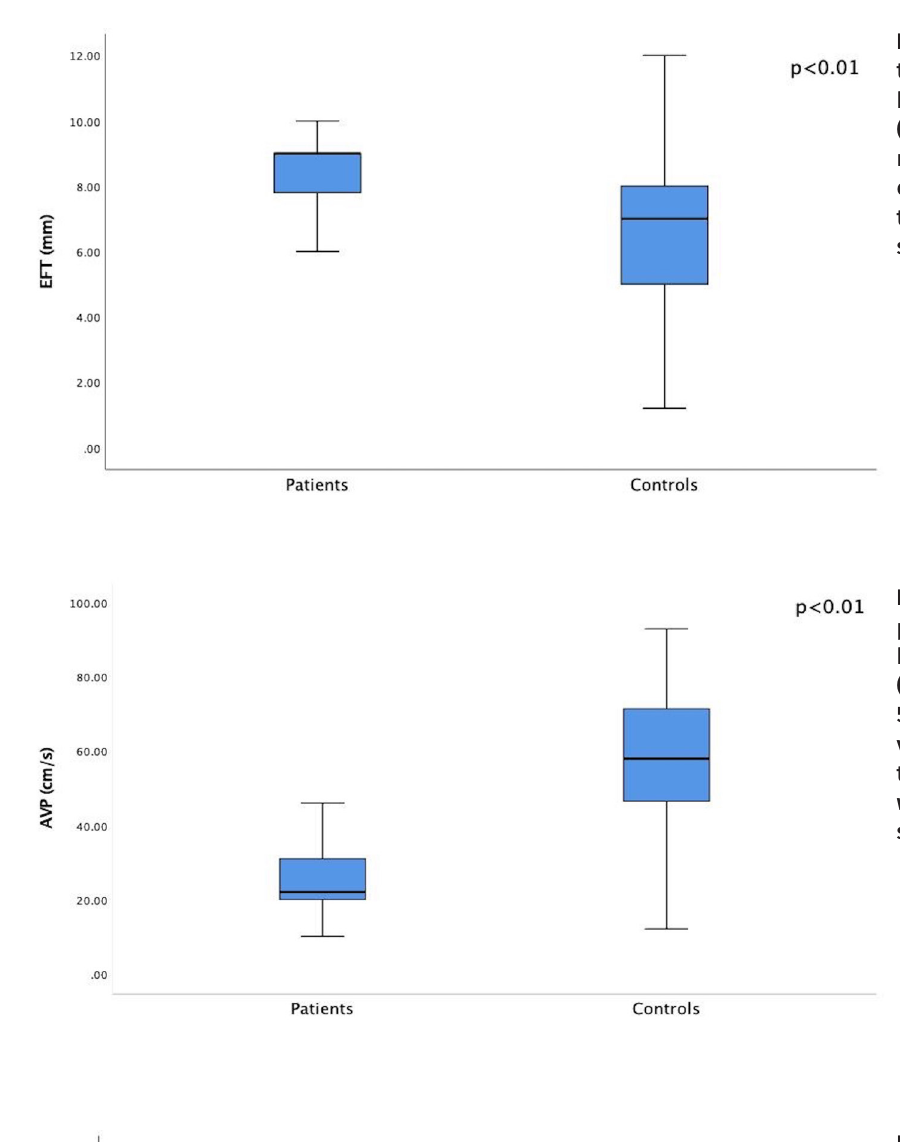
Figure 5. Carotid intima- media thickness (CIMT) levels between study groups. (0.9±0.2 mm vs 0.5±0.1 mm p<0.01). p value was calculated by the student’s t test. p<0.05 was considered statistically